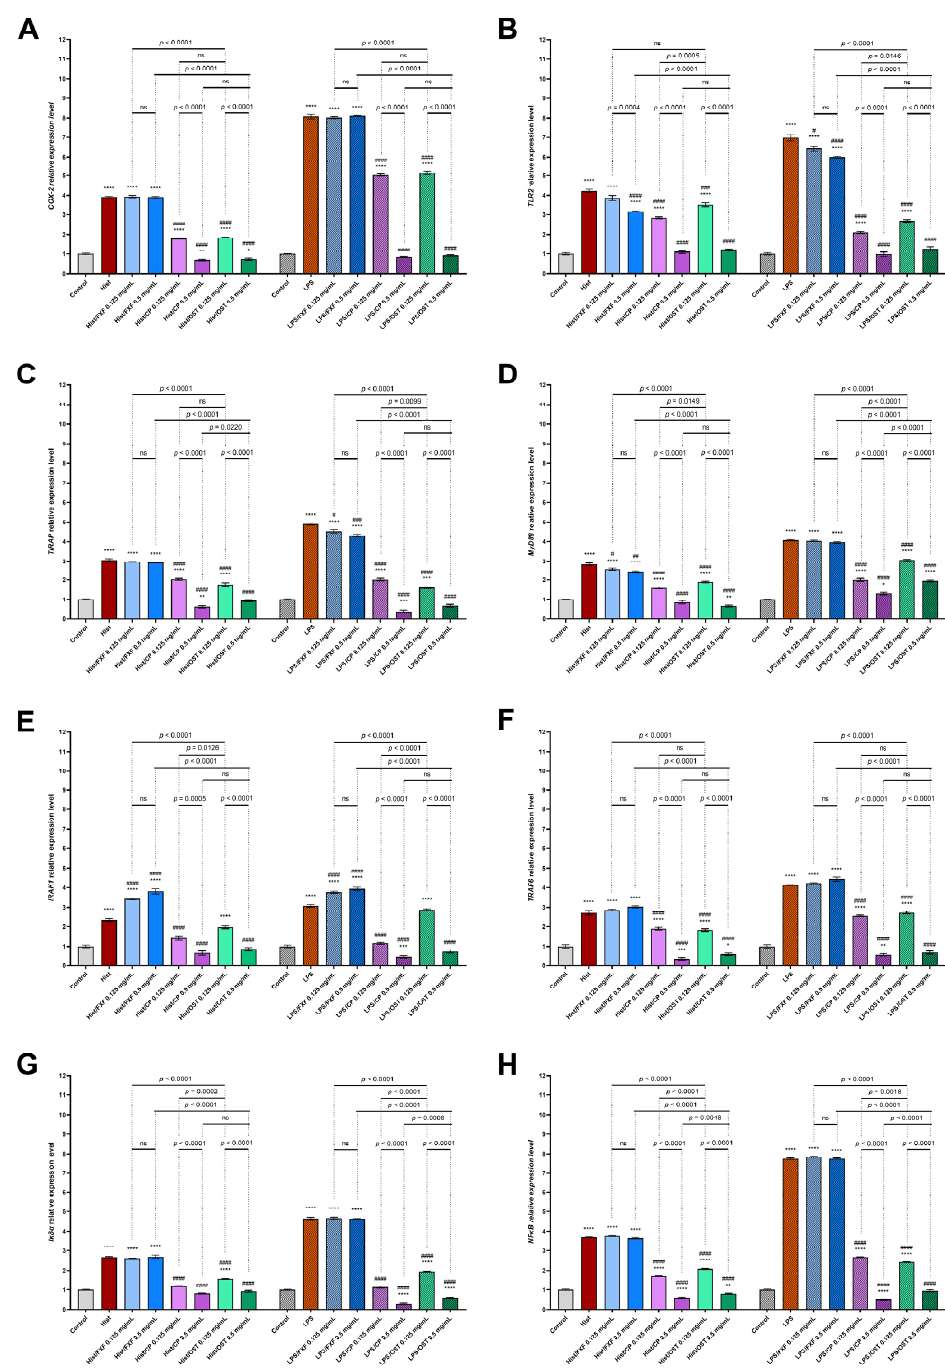
Figure 7. The expression of COX- 2 and genes involved in TLR2 signaling pathway in 3D organotypic skin model. Expression of COX-2 ( A ); TLR2 ( B ); TIRAP ( C ); MyD88 ( D ); IRAK1 ( E ); TRAF6 ( F ); I κ B α ( G ) and NF κ B ( H ) after incubation with histamine (Hist; 100 µ g/mL) or lipopolysaccharides (LPS 2 µ g/mL) alone and in mixtures with fexofenadine (FXF) clobetasol propionate (CP) and osthole (0.125 and 0.5 mg/mL) are shown. The horizontal line shows the mean and the bars show the standard error of the mean. Statistically significant differences (two-way ANOVA followed by Tukey’s multiple comparison test) compared to control (*— p < 0.05, **— p < 0.01, ***— p < 0.001, ****— p < 0.0001) and to cells treated with histamine or LPS (#— p < 0.05, ##— p < 0.01, ###— p < 0.001, ####— p < 0.0001) are marked;